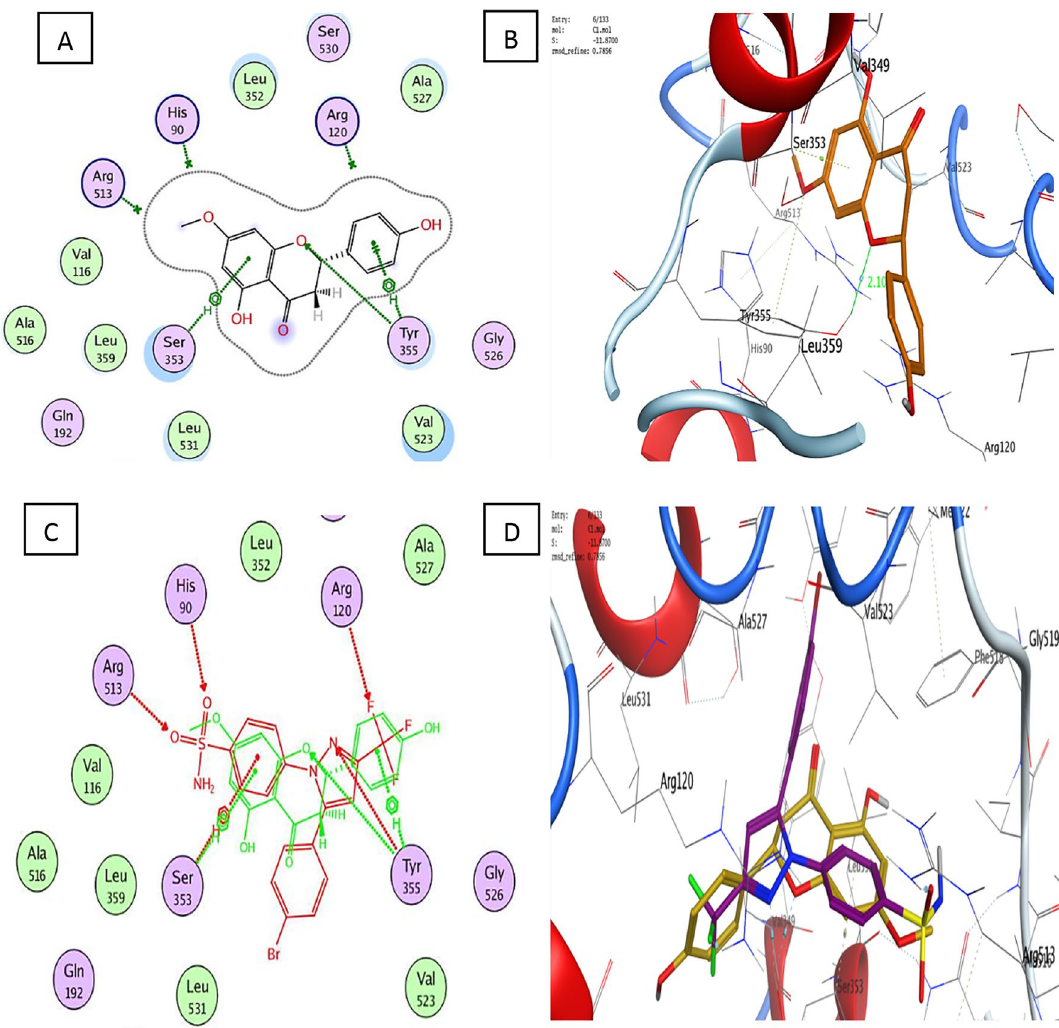
Figure 4. Docking and binding pattern into COX-2 active site (PDB 1CX2) of Target compound C1, 2D ( A ), 3D ( B ), an overlay of the docked pose of compound C1 with co-crystalized ligand S58 2D ( C ), 3D (D) S58 (purple), C1 (yellow). Regarding compound C2, 2D ( E ), 3D ( F ), an overlay of the docked pose of compound C2 with co-crystalized ligand S58 2D ( G ), 3D ( H ) S58 (purple), C2 (yellow). Concerning C4, 2D ( I ), 3D ( J ), an overlay of the docked pose of compound C4 with co-crystalized ligand S58 2D ( K ), 3D ( L ) S58 (purple), C4 (yellow). Finally target compound C5, 2D ( M ), 3D ( N ), an overlay of the docked pose of compound C5 with co-crystalized ligand S58 2D ( O ), 3D ( P ) S58 (purple), C5